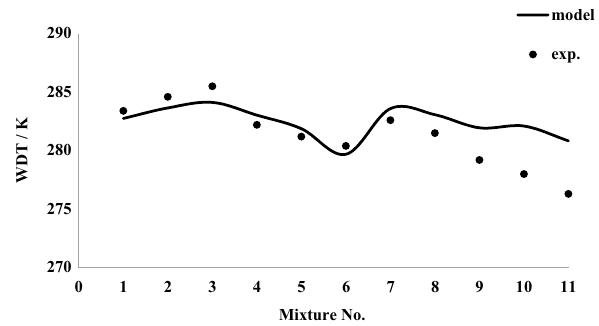
Fig. 4 Comparison of experimental (Metivaud et al. 1999) and pre- dicted WDT vs. mixture number for system #1